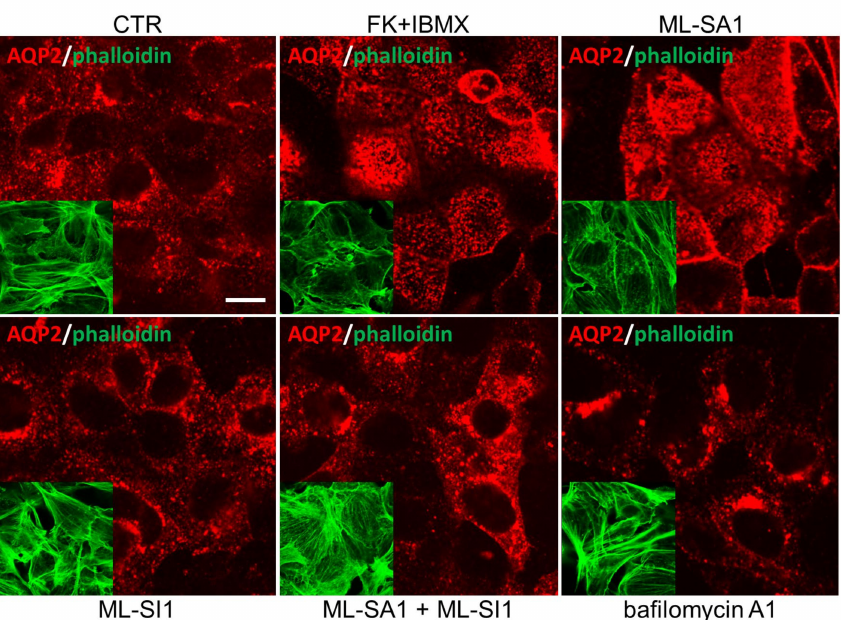
Figure 6. ML-SA1 and bafilomycin A1 differentially modulate AQP2 intracellular localization and cytoskeleton remodeling in MCD4 cells. M1 cells were left unstimulated (CTR) or underwent the following treatments: 100 µ M FK+ 500 µ M IBMX for 15 min; 100 µ M ML-SA1 for 15 min; 25 µ M ML-SI1 for 30 min either alone or followed by a co-incubation with ML-SA1; 100 nM bafilomycin A1 for 30 min. Cells were stained with an antibody against AQP2 (red) and phalloidin Alexafluor-488 to visualize F-actin (green, inset). Images are representative of 3 independent experiments. Scale bar: 20 µ m.